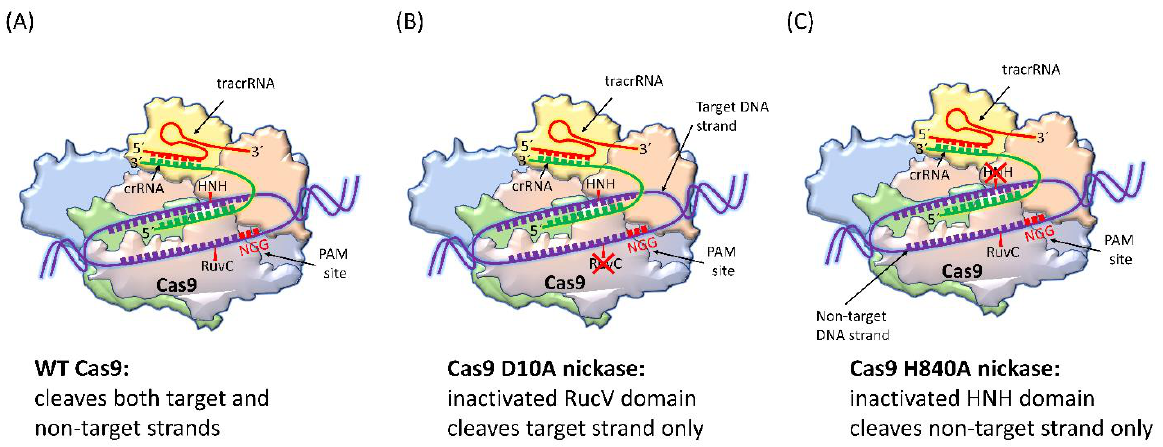
Figure 3. Generation of target strand and non-target strand SSBs by Cas9 nickase. ( A ) WT Cas9 possesses active HNH and RuvC domains, which cleave both the strands of target DNA, while ( B ) Cas9 D10A nickase cleaves only target strand DNA due to its inactive RuvC domain, and ( C ) Cas9 H840A nickase cleaves only non-target strand due to its inactive HNH domain.